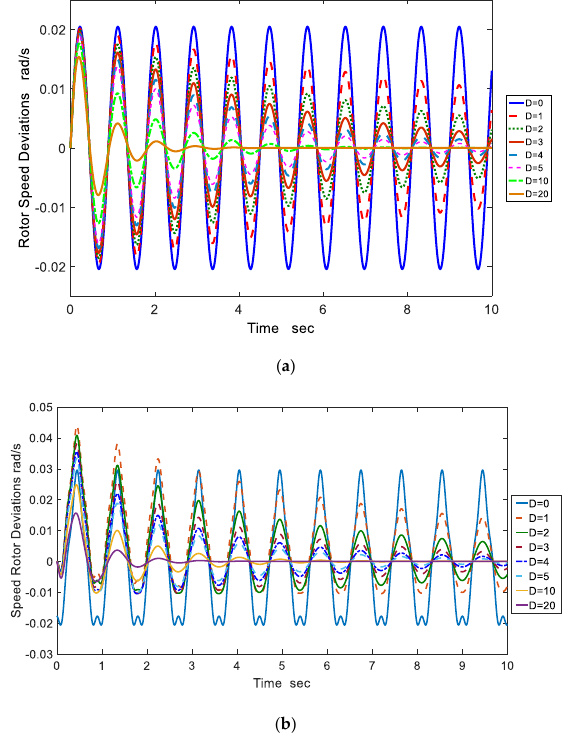
Figure 8. Time evolution after a unit step function applied to the transfer functions varying the damping coefficient: ( a ) linear transfer function; ( b ) second order transfer function.